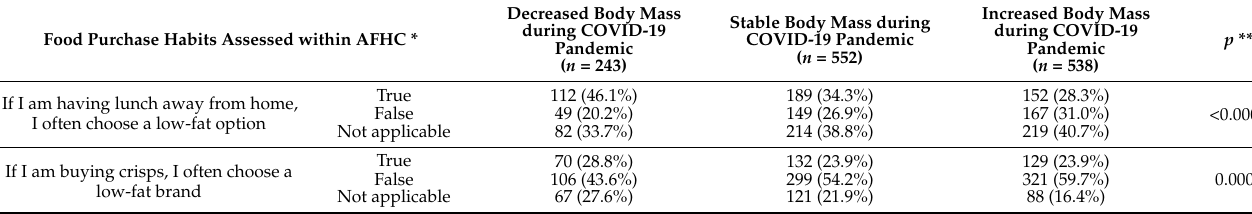
Table 4. The food purchase habits assessed while using Adolescents’ Food Habits Checklist (AFHC) in the period during the COVID-19 pandemic, as declared by the adolescents from the Diet and Activity of Youth during COVID-19 (DAY-19) Study cohort ( n = 1333) in sub-groups of adolescents declaring decreased, stable, and increased body mass during the COVID-19